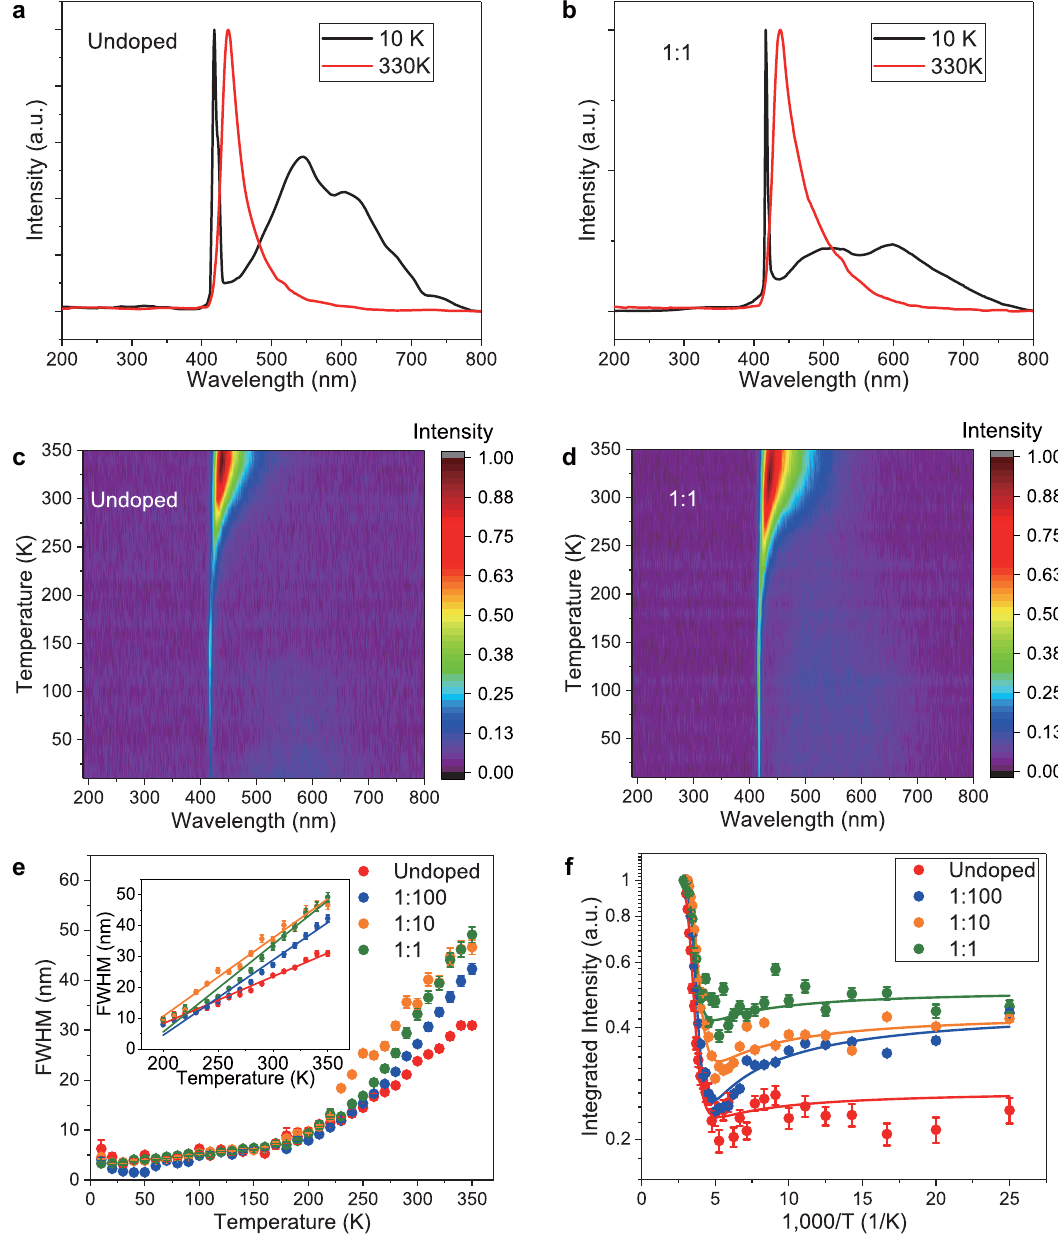
Fig. 2 Temperature-dependent X-ray luminescence. X-ray luminescence spectra at representative temperature, 10 and 330 K from a undoped and b 1:1 Li- (PEA) 2 PbBr 4 . Temperature-dependent X-ray luminescence spectra from 10 and 350 K from c undoped and d 1:1 Li-(PEA) 2 PbBr 4 . e Comparison of FWHM versus temperature among different Li-doped crystals. f Comparison of the negative thermal quenching